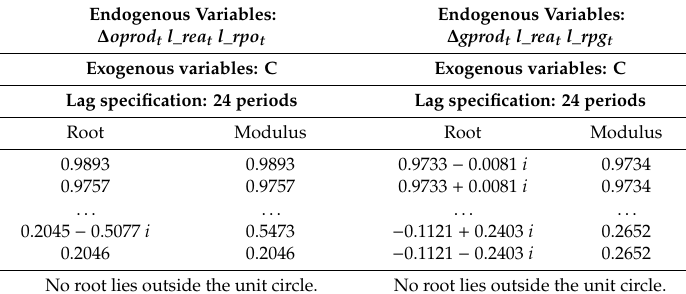
Table A1. The results of SVAR stability Condition Table B1. The results of SVAR stability Condition Check.